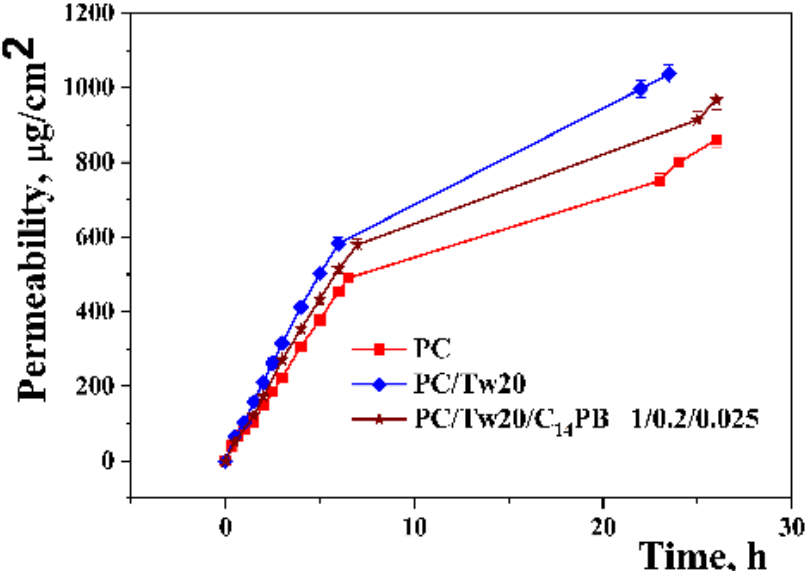
Figure 4. Ex vivo penetration of transfersomes with 2- PAM (μg/cm 2 ), phosphate buffer (0.025 M), pH = 7.4, 34 °C.